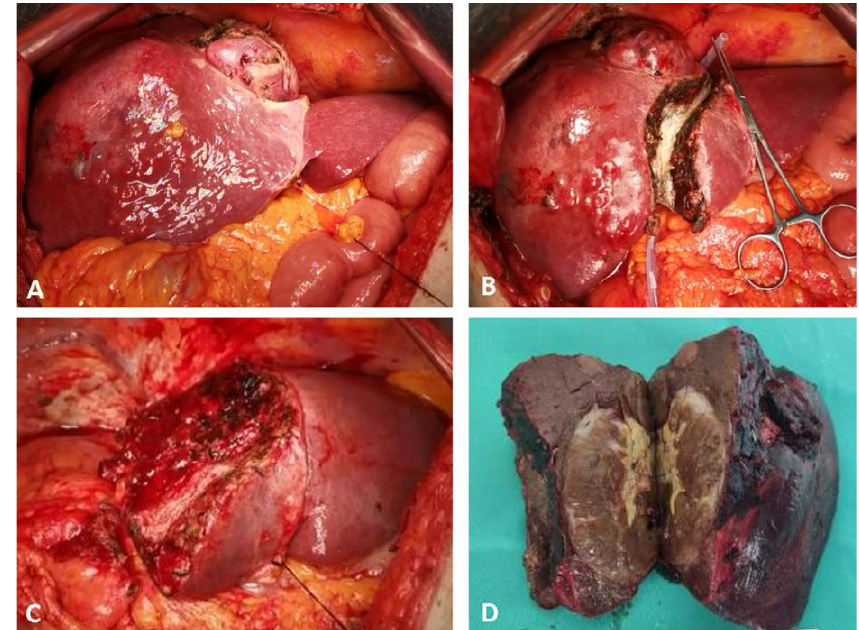
Figure 1. Intraoperative aspects of parenchymal sparing ALPPS in a 67-year-old male patient, for a large HCC located in segments 4, 5, 6, 7 and 8, with satellites in segment 4, on HBV chronic hepatitis. Stage 1: ( A ) intraoperative aspect at exploration; ( B ) ultrasound-guided partitioning of the liver through segment 4, adding the non-tumoral parenchyma of segment 4 to the FLR. Stage 2 after an interstage interval of 14 days; ( C ) remnant liver after completion of right hemi-hepatectomy non-anatomically extended to segment 4; ( D ) surgical specimen. No intraoperative adverse events were encountered during both operations, and only minor ascites after stage 2 were recorded as complications.